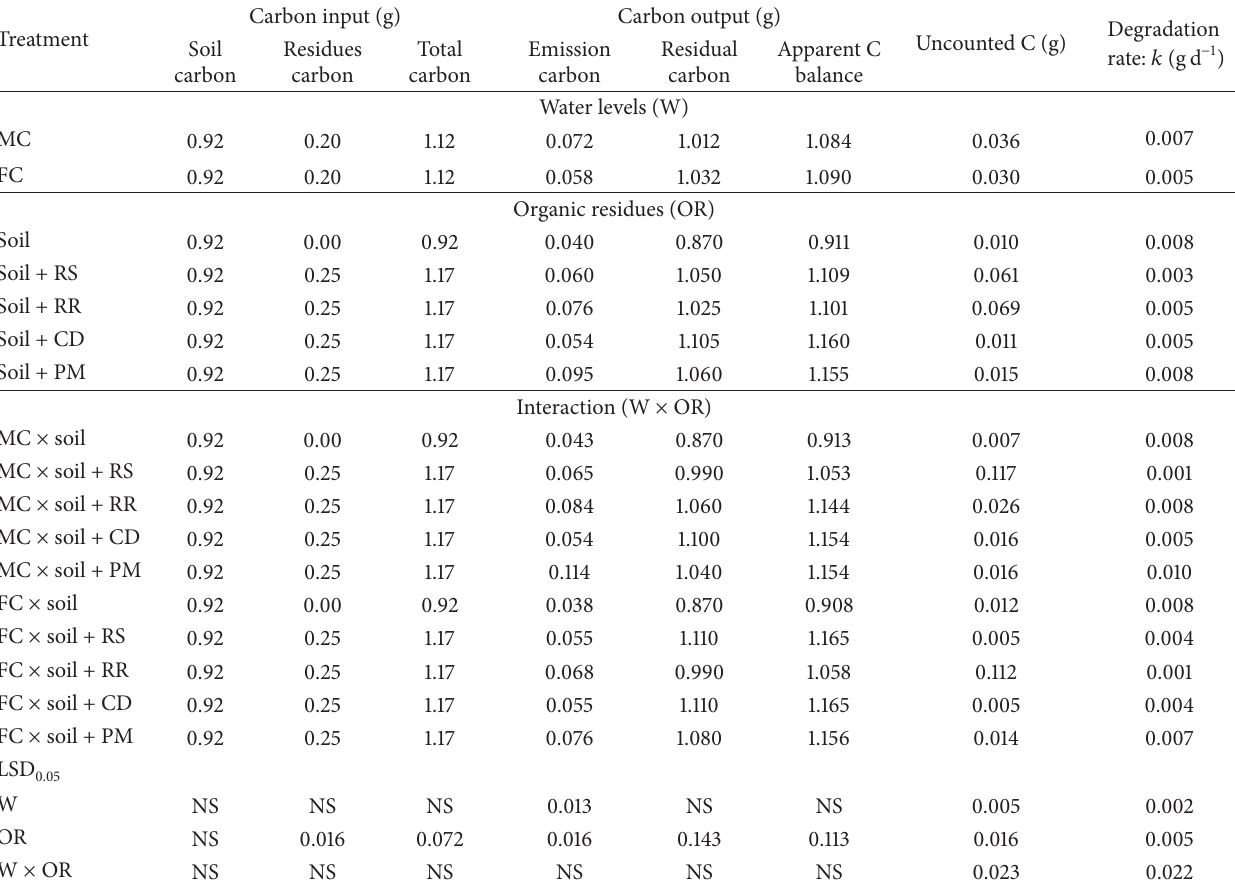
Table 3: Carbon balance from different organic residues in 100g